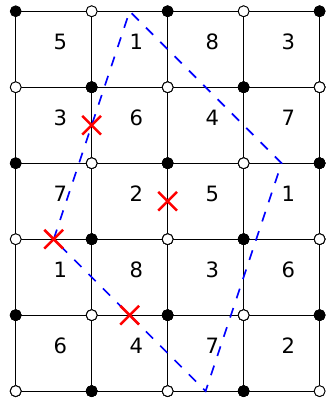
Figure 13 . PdP 5 0